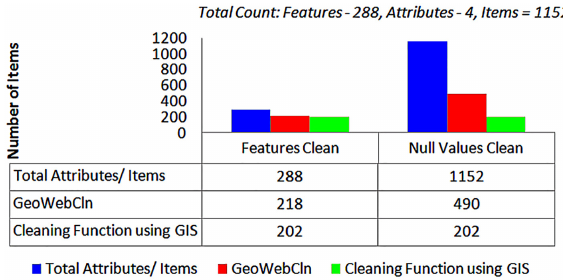
Fig. 16. Performance analysis of GeoWebCln